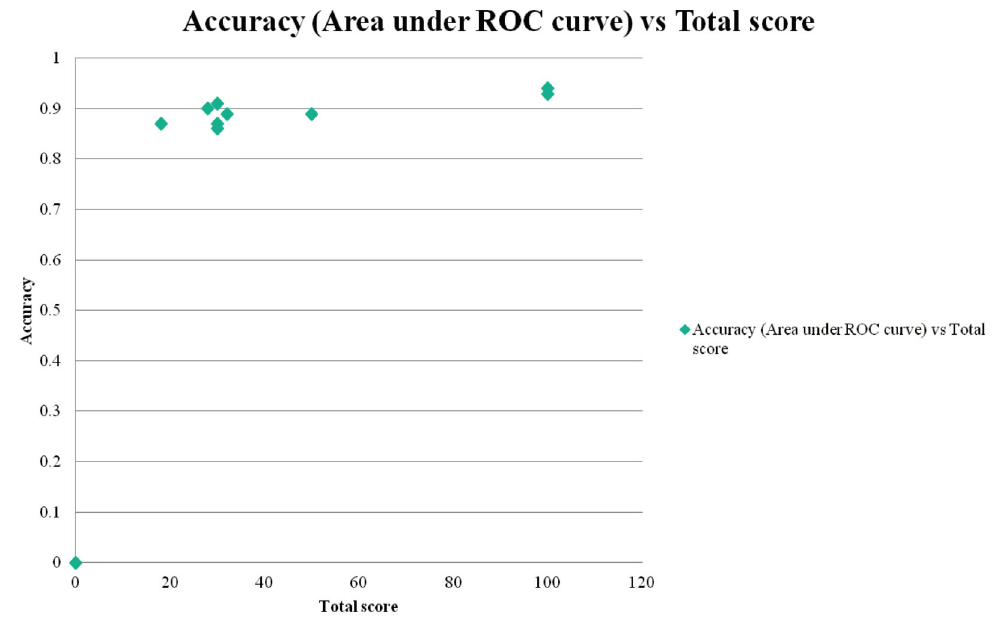
Figure 3. Scatter plot of area under ROC curve versus total test score (= surrogate measure of test administration time).